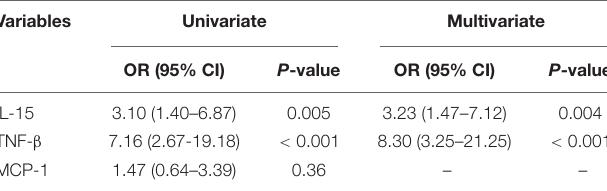
TABLE 3 | The logistic analysis for the relationship between analyzed cytokines and growth risk of